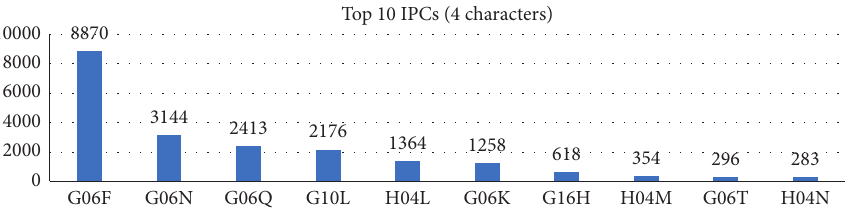
Figure 3: Top 10 IPCs (4 characters).